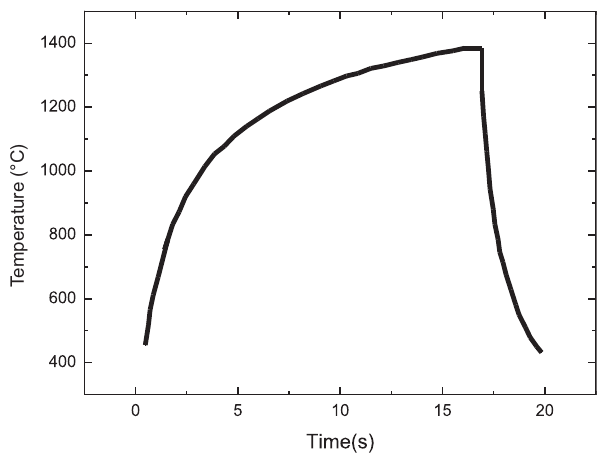
Figure 4: Temperature used in experiment [59].